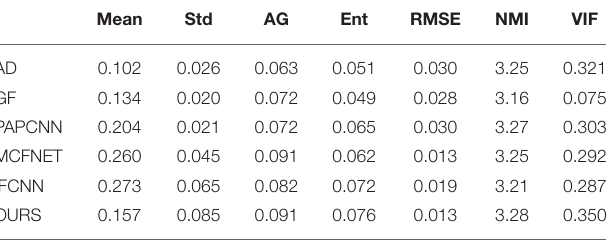
TABLE 1 | Evaluation metric of different fusion algorithm results.